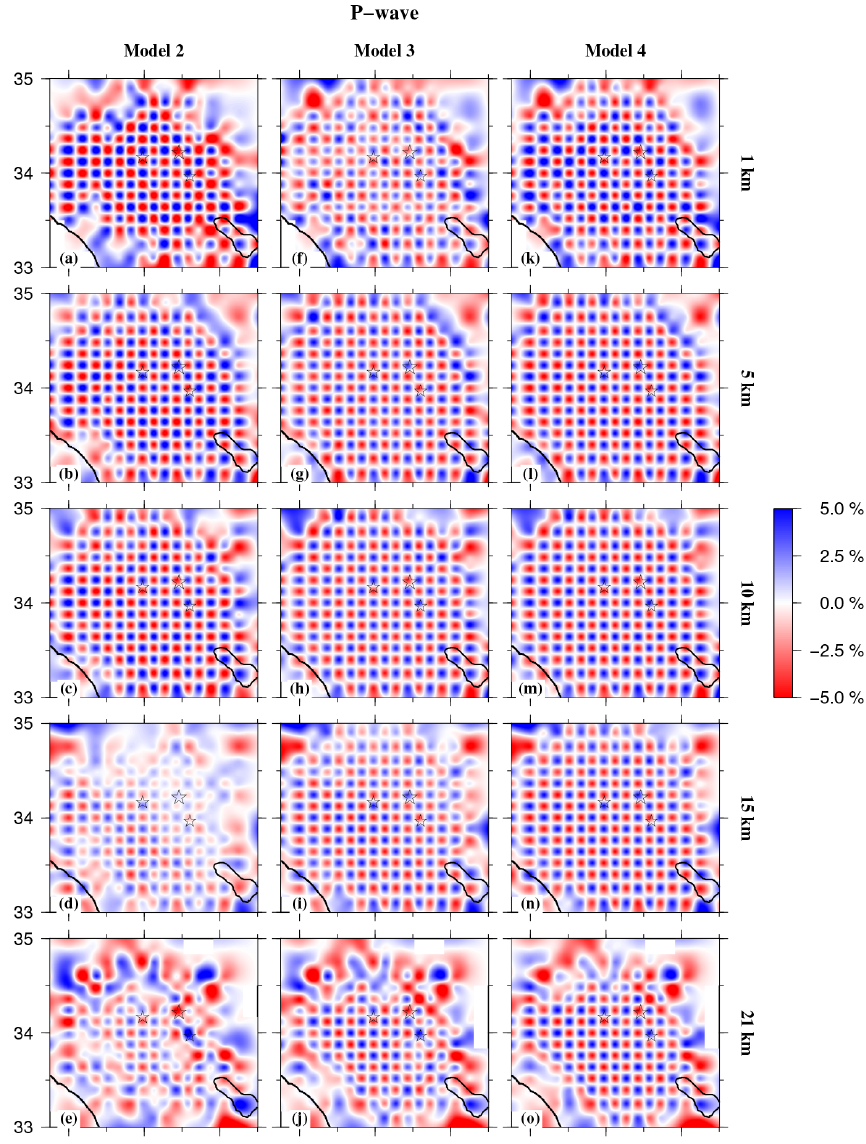
Figure 8. Iterative results m 2 (a–e) , m 3 (f–j) , and m 4 (k–o) of a checkerboard resolution test for P wave velocity structure at five represen- tative depth layers (1.0, 5.0, 10 . 0, 15 . 0, and 21 . 0km). Red and blue colors denote low- and high-velocity perturbations, respectively. The velocity perturbation in percentage scale is shown at the right hand side. The stars denote the epicentral locations of the Landers, the Joshua Tree, and the Big Bear